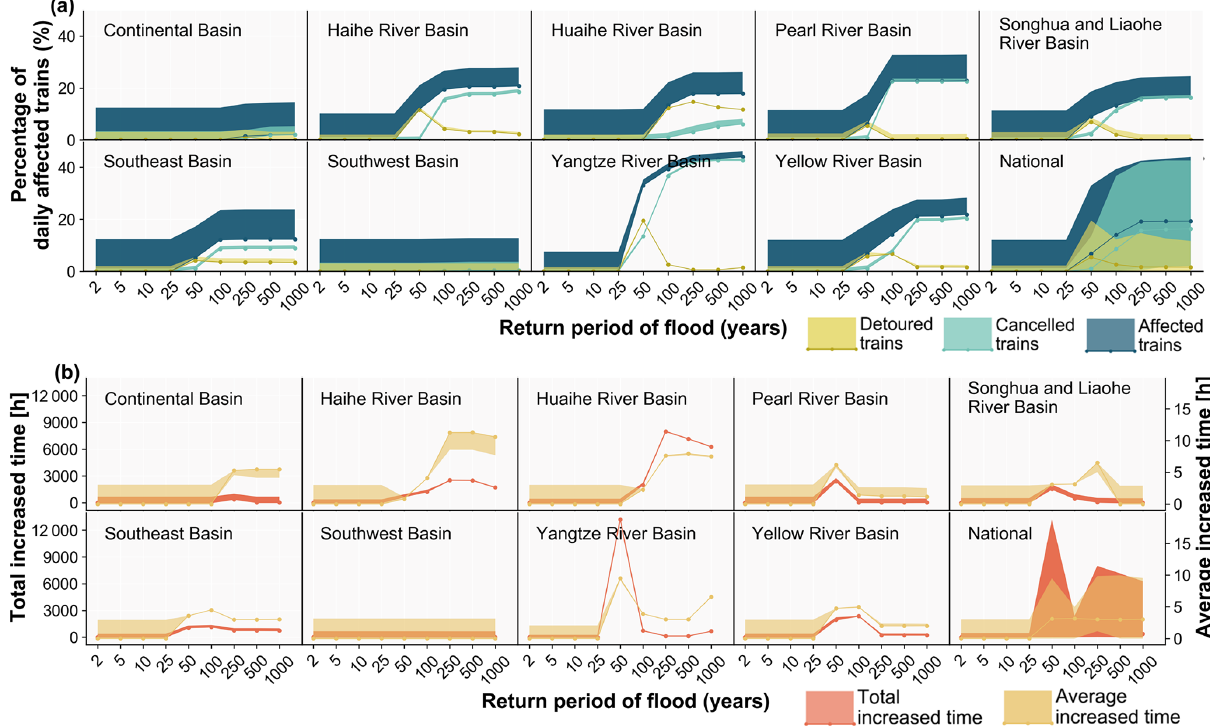
Figure 7. System vulnerability curves induced by river floods from the national flood event set, showing (a) the percentage of daily affected trains relative to the total number of daily trains and (b) the increased time for the detoured trains. The shading shows the distribution of the flood performance loss, where the lines refer to the median performance loss value and the bounded lines refer to the 10th and 90th percentiles. In Appendix Fig. A6, we provide the system vulnerability curves for the passenger-level metrics. NB: for total increased travel time, the values can decrease at higher return periods – this is because some of the trains are cancelled, and therefore there is no travel time for those